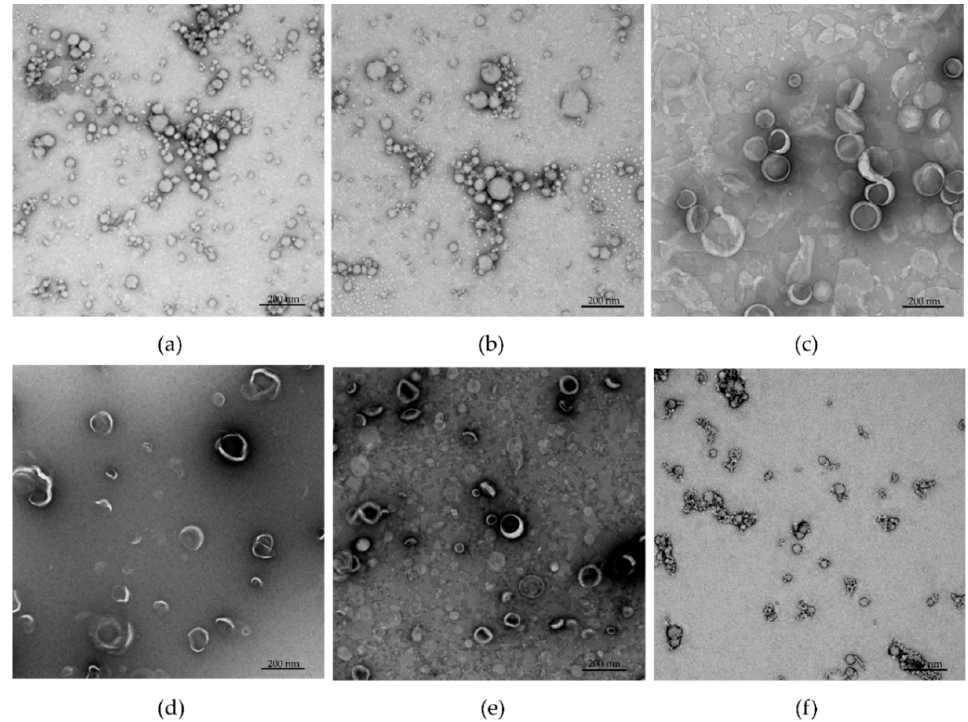
Figure 3. Transmission electron micrograph of ( a ) 1 , ( b ) 1-Tr , ( c ) L-0 , ( d ) L-1 , ( e ) L-1-Tr , and ( f ) 2 , stained with 2% uranyl acetate.